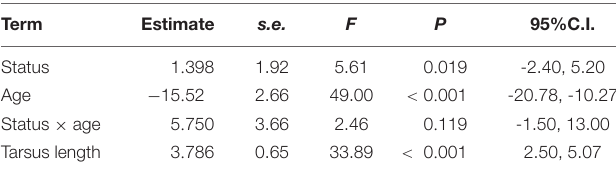
TABLE 3 | Results of LMMs for body condition (body mass corrected by tarsus length) in breeding common kestrel females as a function of dispersal status (immigrant vs. resident), age (young vs. adult) and the interaction between dispersal status and age.